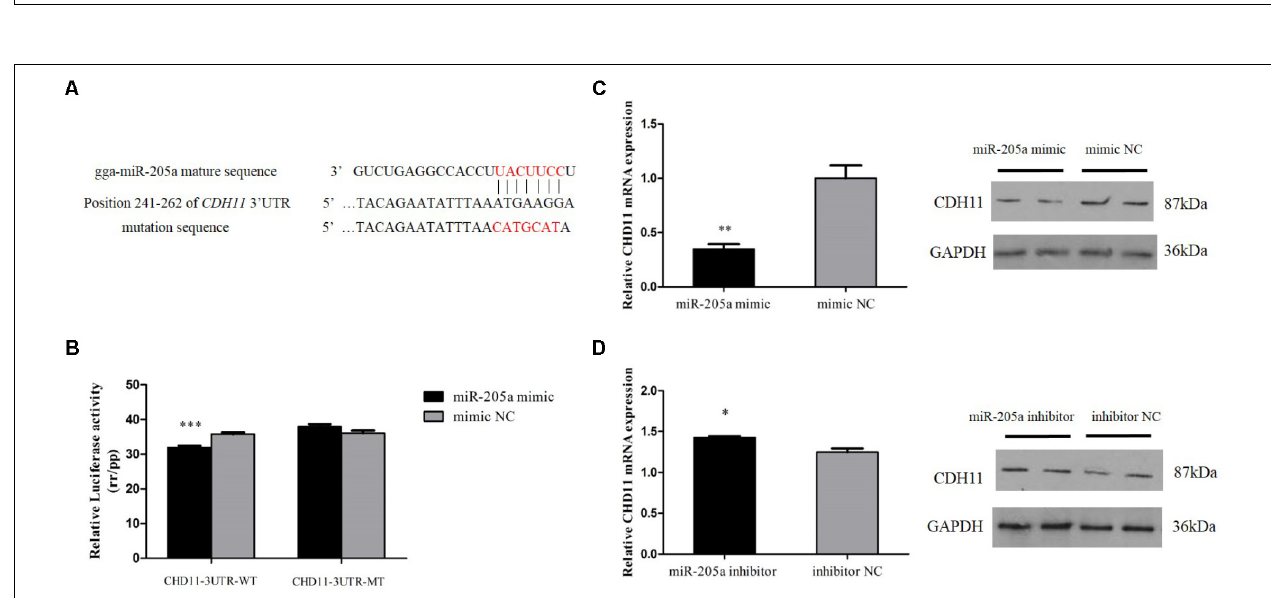
FIGURE 3 | CDH11 is a direct target of miR-205a. (A) The miR-205a binding site in the CDH11 mRNA 3 (cid:48) UTR. The seed sequence and mutant sequence in miR-205a is highlighted in red. (B) The dual-luciferase reporter assay was performed by co-transfecting wild-type or mutant CDH11 3 (cid:48) UTR with miR-205a mimic of mimic NC in DF-1 cells. (C,D) The mRNA and protein level of CDH11 from miR-205a mimic and inhibitor transfected CPM cells. Results are shown as mean ± SEM and the data are representative of at least three independent assays. Independent sample t -test was used to analyze the statistical differences between groups. ∗ P < 0.05; ∗∗ P < 0.01; ∗∗∗ P <